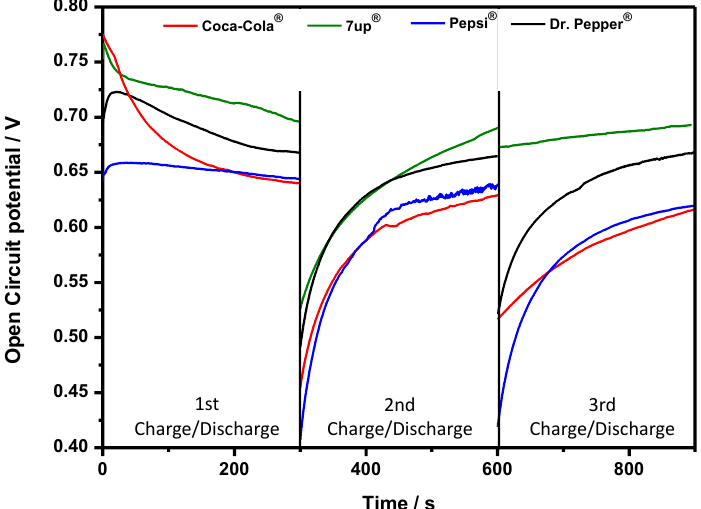
Figure 7. Open circuit potential stability, for a paper-based µ FCs for cases 7up R (cid:13) , Coca Cola R (cid:13) , (cid:13) (cid:13) Dr. Pepper R , and Pepsi R